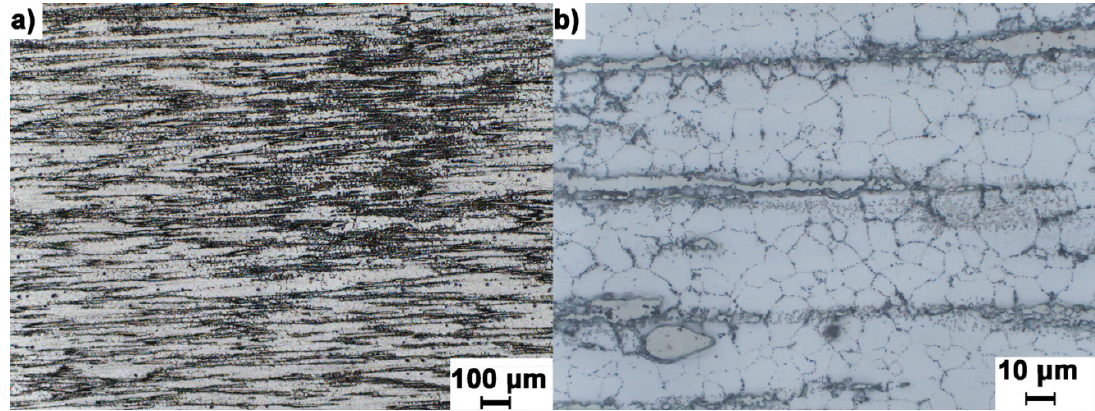
Figure 3. Microstructure of sand casting AZ91 (MgAl9Zn1) magnesium alloy after extrusion with the conventional method with the degree of processing λ = 45, longitudinal section observed with different magnification, ( a , b ) respectively.